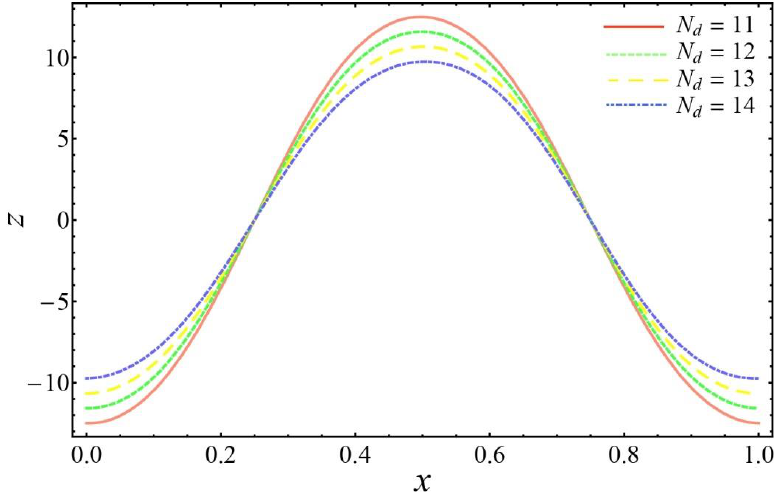
Figure 13. Alteration of 𝑁 𝑑 on 𝑧 when 𝑡 = 0; 𝑄 = 10; 𝛽 = 0.2; 𝜖 = 0.2; 𝑁 𝑡 = 15; 𝑁 𝑏 = 20; 𝑘 = 2.